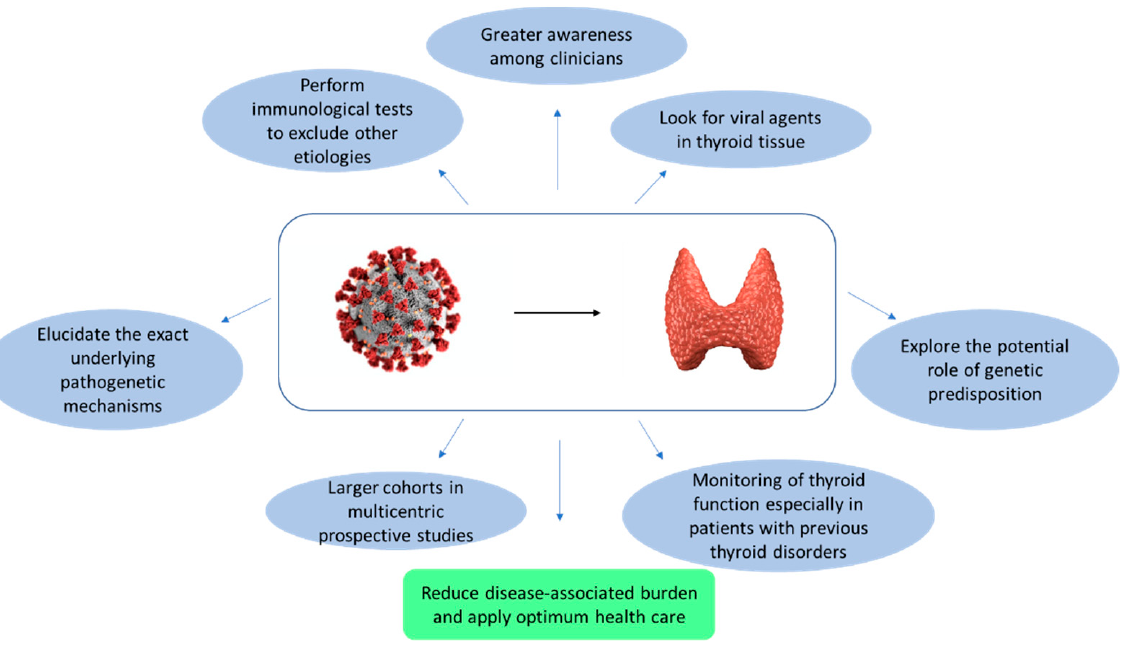
Figure 2. Actions to be taken to verify the nature and strength of the relationship between COVID-19 (or other viral infections) and thyroid disorders.